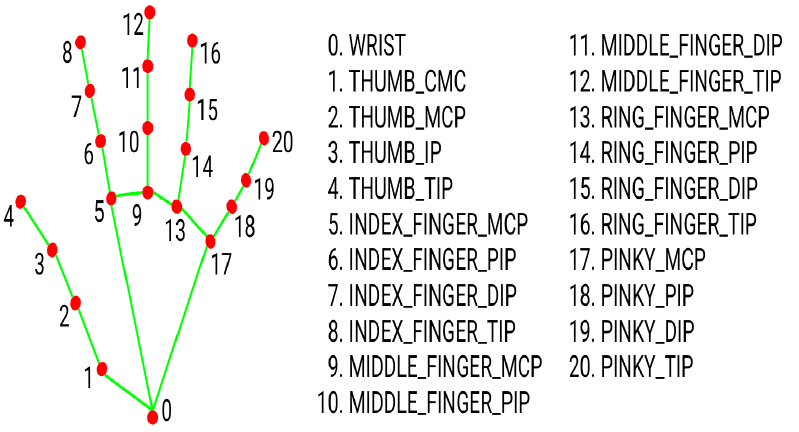
Figure 4. The order and labels of MediaPipe’s Hands keypoints